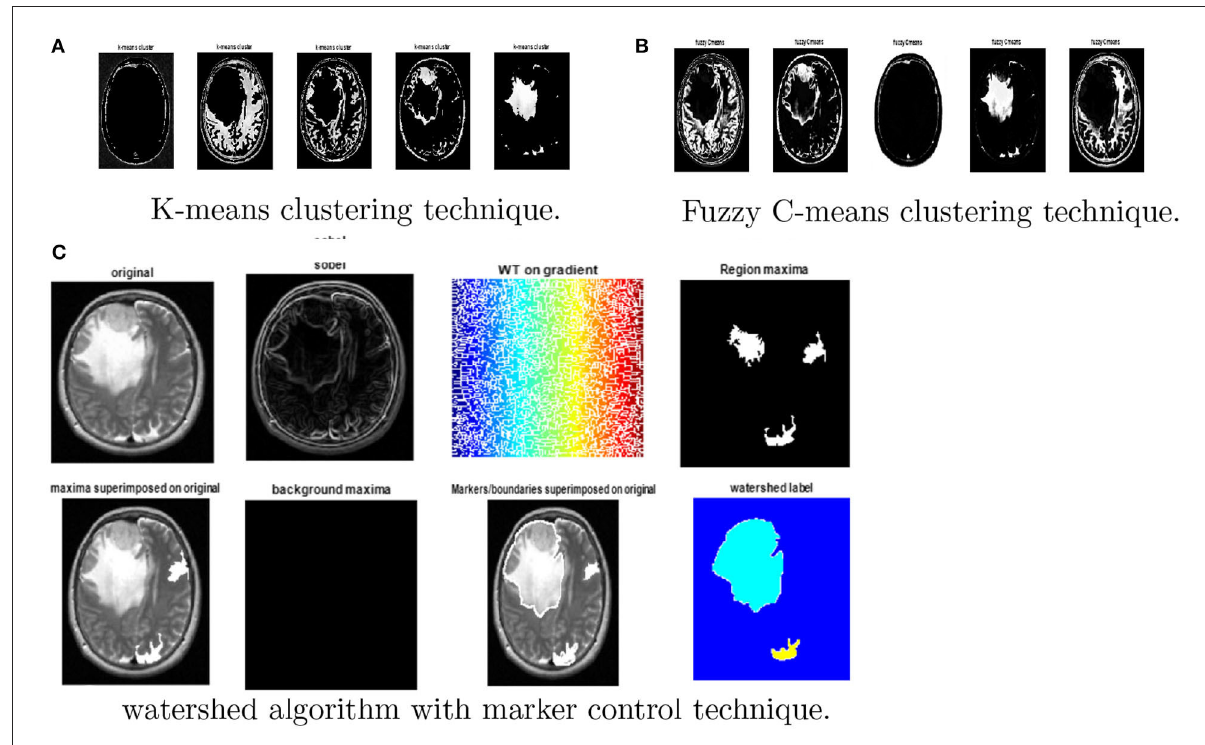
FIGURE8 Results obtained from watershed algorithm with marker control technique. (A) K-means clustering, (B) Fuzzy c-means clustering, and (C) watershed algorithm.